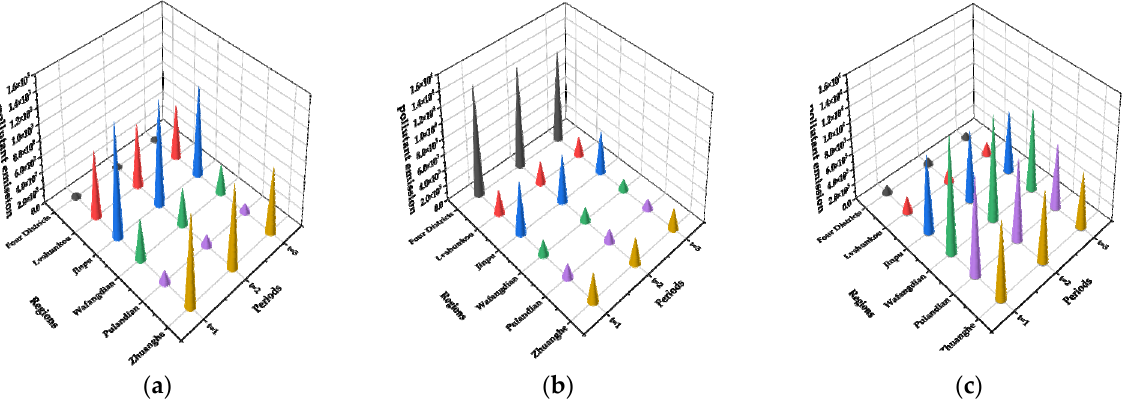
Figure 10. Chemical oxygen demand (COD) emissions of various sectors: ( a ) industry; ( b ) municipal; ( c ) agriculture (tons/year).